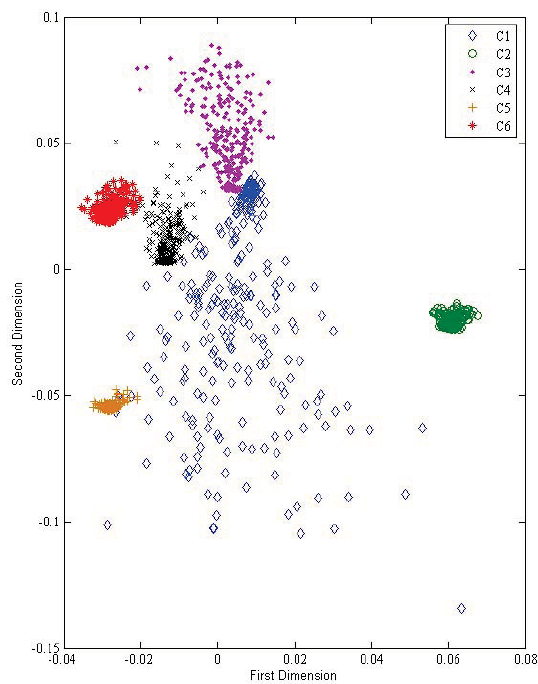
Figure 3. Classification result of the